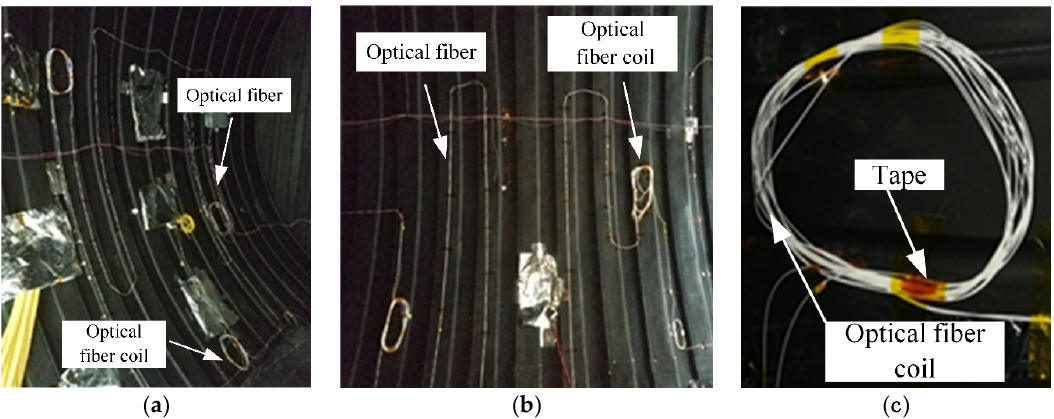
Figure 5. ( a ) Optical fiber on the left side of the heatsink; ( b ) optical fiber on the right side of the heatsink; ( c ) enlarged picture of the optical fiber coil inside the heatsink.